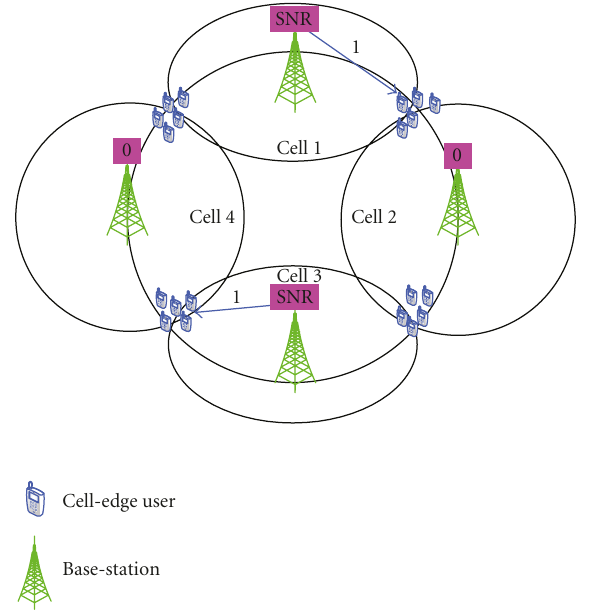
Figure 3: SCP with